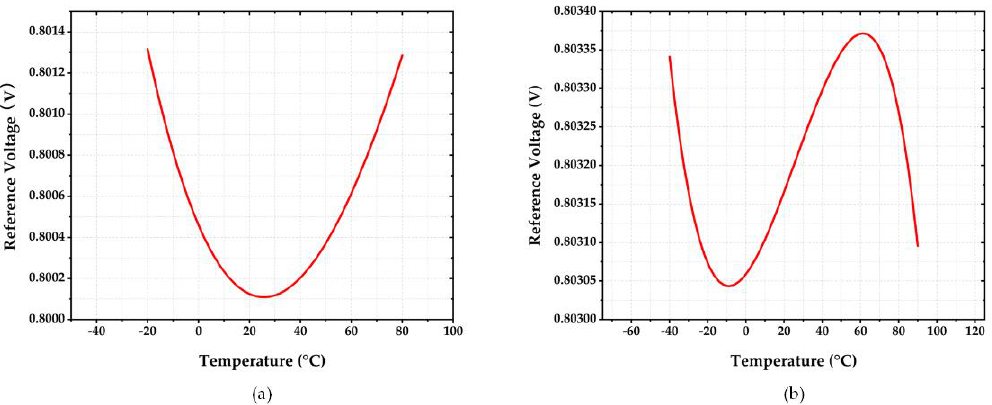
Figure 10. T.C. of 𝑉 𝑟𝑒𝑓 in the TT Corner Case ( a ) Circuit with 1st-order temperature compensation Figure 10. T.C. of V ref in the TT Corner Case ( a ) Circuit with 1st-order temperature compensation ( b ) Circuit with 2nd-order temperature compensation. ( b ) Circuit with 2nd-order temperature compensation.